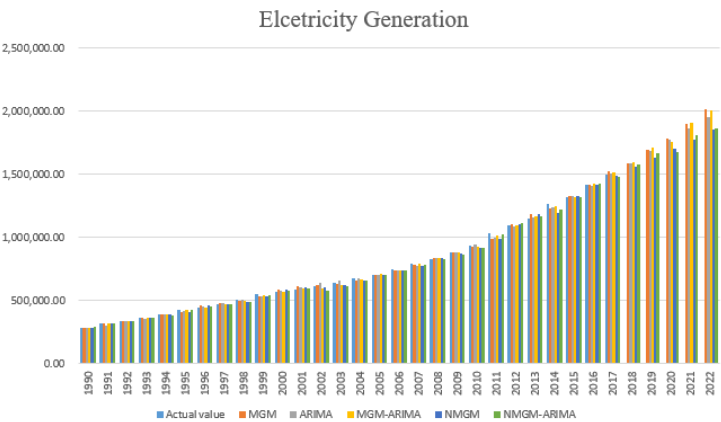
Figure 22. The predicted value of the five models and the actual power generation. (Column chart, GWh).